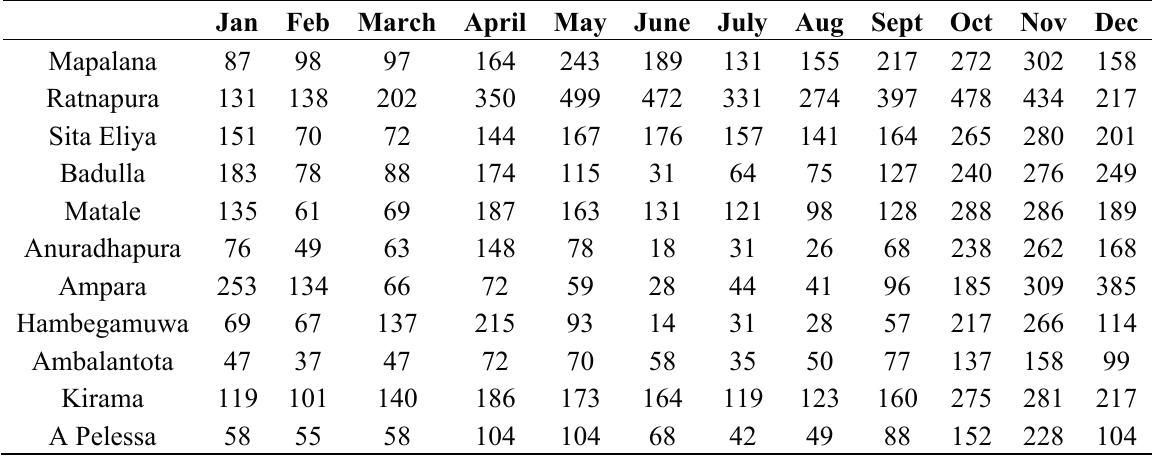
Table 1. ( a ) Mean monthly and ( b ) mean seasonal and mean annual rainfall (1976–2006) for the stations included in this study. Totals are in